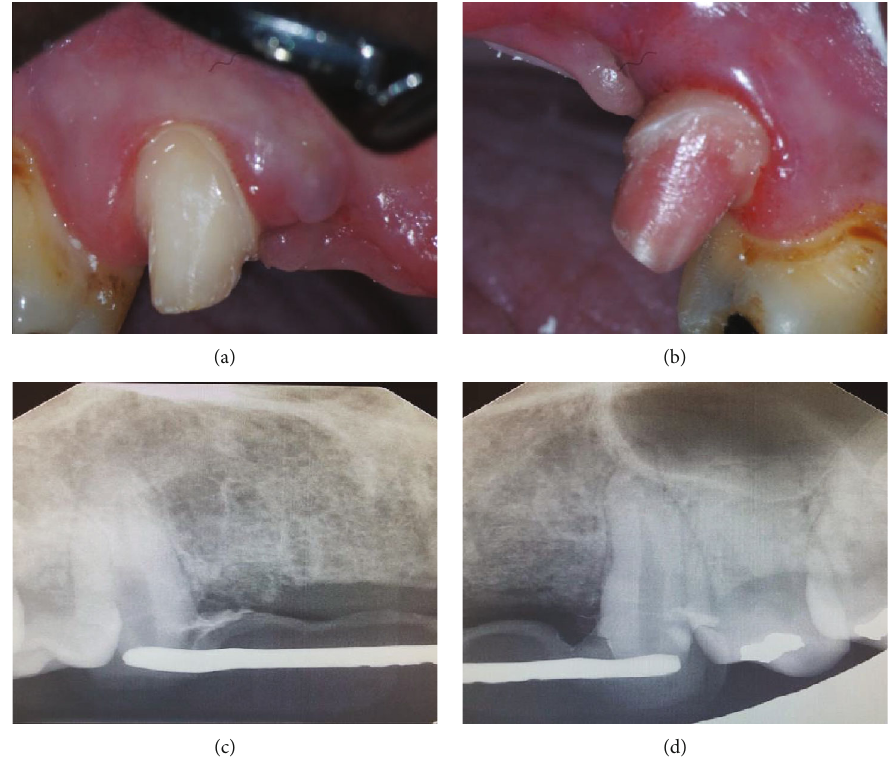
Figure 1: (a) Clinical photograph of tooth #6 after the removal of provisional FPD, normal clinical appearance. (b) Clinical photograph of tooth #11 after the removal of provisional FPD, red hue appearance. (c) Radiograph of tooth #6 before the removal of provisional FPD. (d) Radiograph of tooth #11 before the removal of provisional